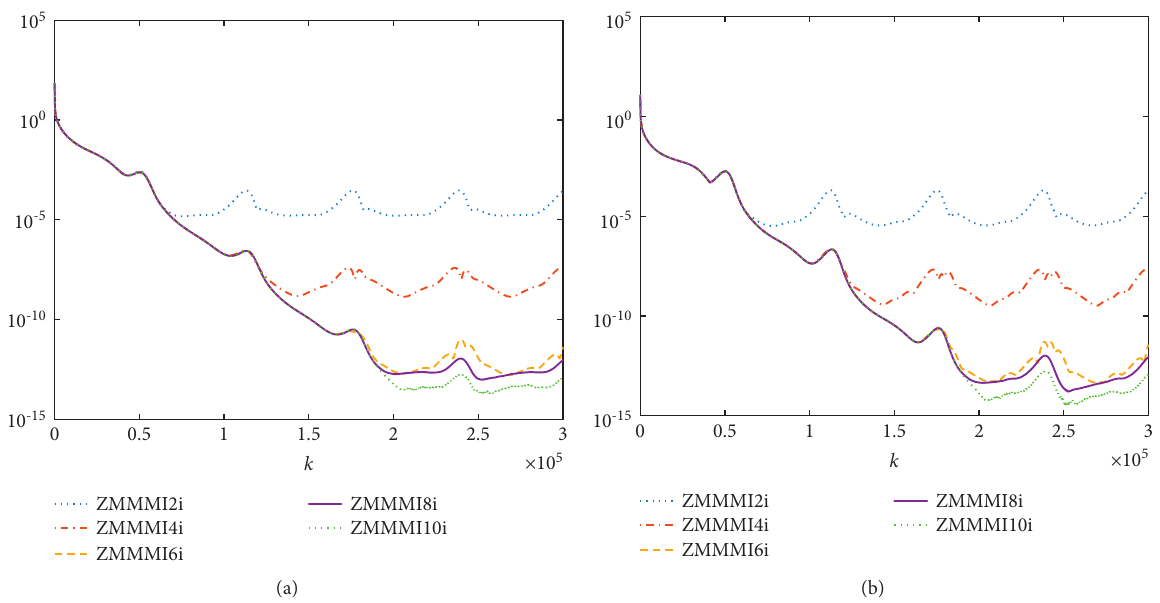
Figure 7: Residual error trajectories synthesized by five ZMMMI algorithms for example 2 (with ϵ � 0 . 0001 s and c � 2 . 0). (a) Trajectories of A − I ‖ ‖ X . (b) Trajectories of ‖ X k + k + 1 k + 1 F